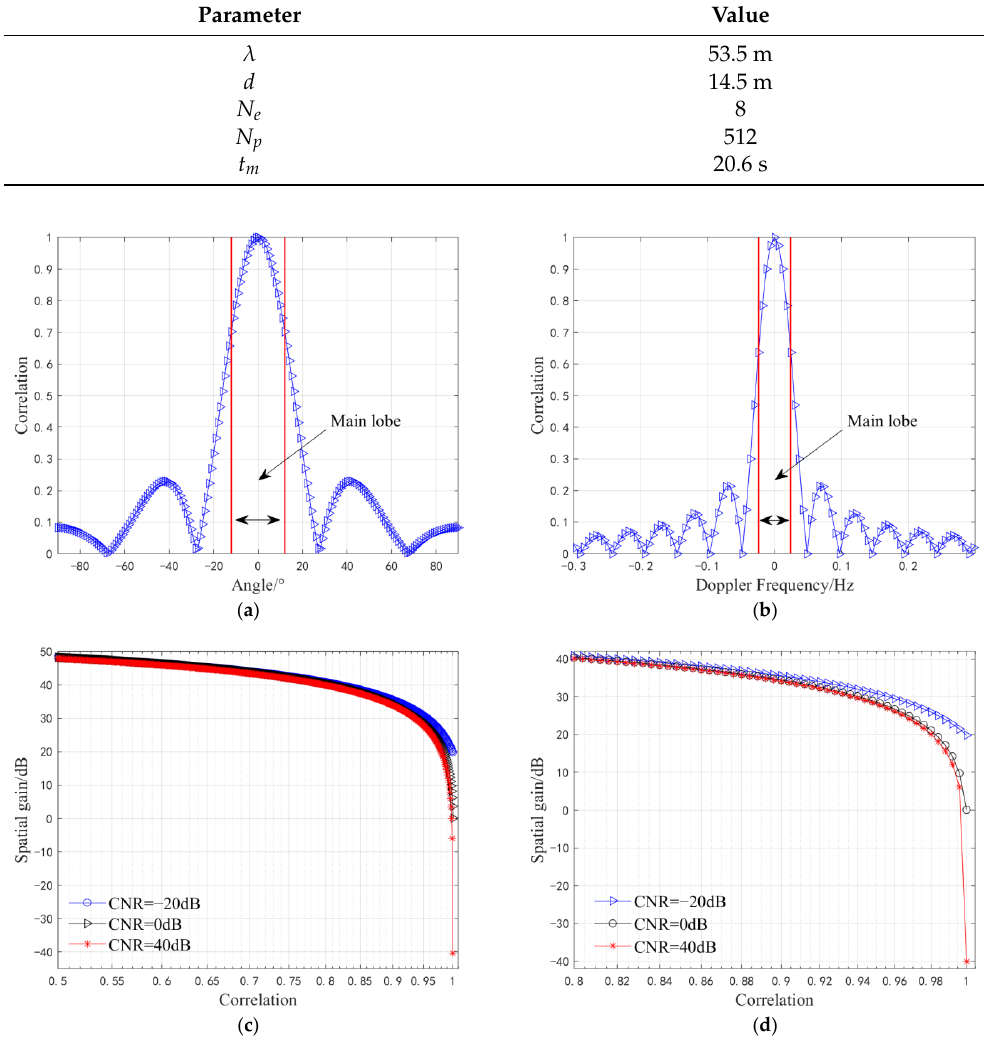
Figure 1. ( a ) Correlation between target and clutter components in the angle domain. ( b ) Correlation between target and clutter components in the Doppler frequency domain. ( c ) Spatial gain in the target direction via the correlation between the clutter component and target for different CNRs. ( d ) Partial enlargement of ( c ).